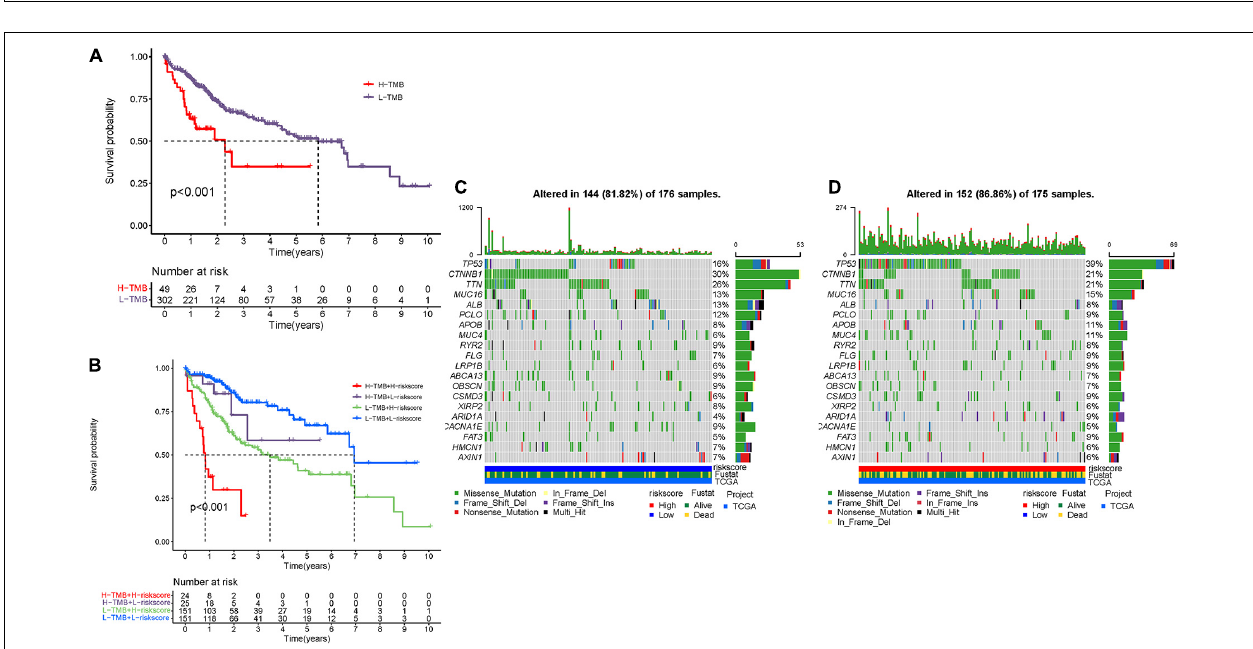
FIGURE 8 | Correlation between prognostic risk signature with hub immune checkpoint genes. (A) Correlation analysis between immune checkpoint inhibitors (CD274, PDCD1, PDCD1LG2, CTLA4, HAVCR2, and IDO1) with prognostic risk signature. (B) Correlation between prognostic risk signature and CD274. (C) Correlation between prognostic risk signature and CTLA4. (D) Correlation between prognostic risk signature and HAVCR2. (E) Correlation between prognostic risk signature and IDO1. (F) Correlation between prognostic risk signature and PDCD1. (G) Correlation between prognostic risk signature and PDCD1LG2.